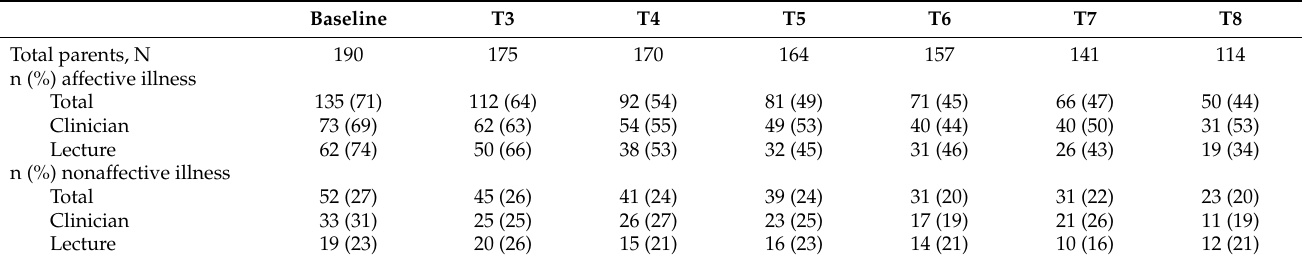
Table 3. Parent-level illness.